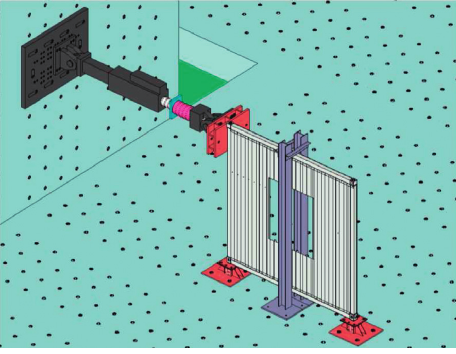
Figure 4: Model of QX-1.